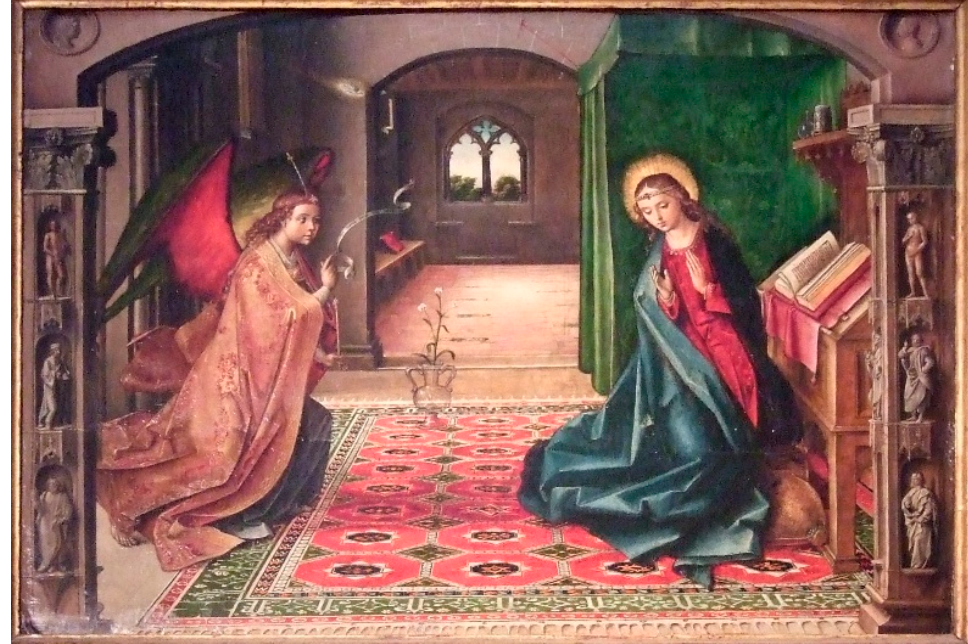
Figure 15. Pedro Berruguete, The Annunciation , c. 1496–1500. Miraflores Charterhouse,